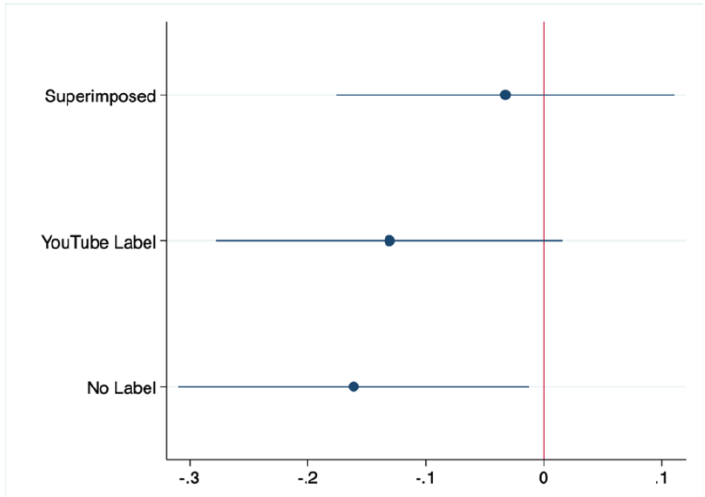
Figure 4. Opinions on trust in outlets representing mainstream media in our July experiment, correction effects are visible by condition. The line at 0 represents the control opinion. Error bars represent 95% confidence